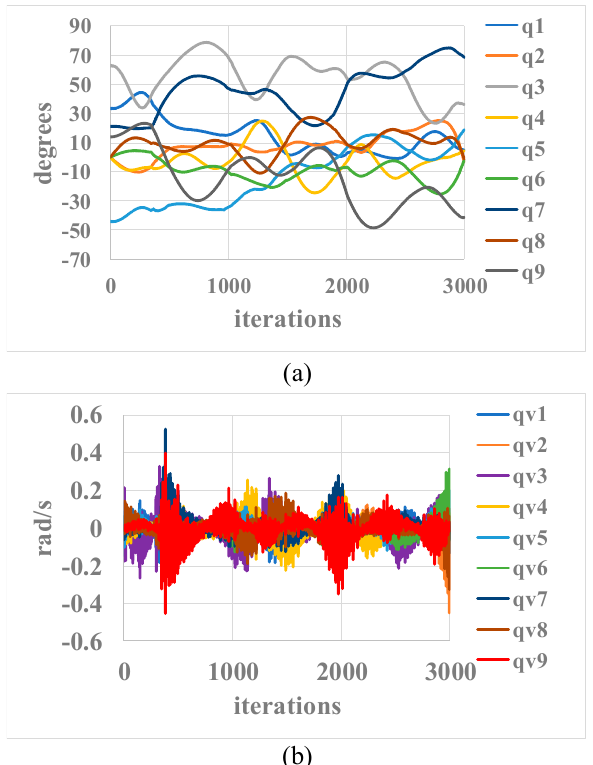
Figure 18. Image error of different strategies in experiment of triple leaf rose path. ( a ) Image error of IBUVS. ( b ) Image error of the original PHUVS. ( c ) Image error of the improved PHUVS with the KF method. ( d ) Image error of the improved PHUVS with the KF-SVSF method.